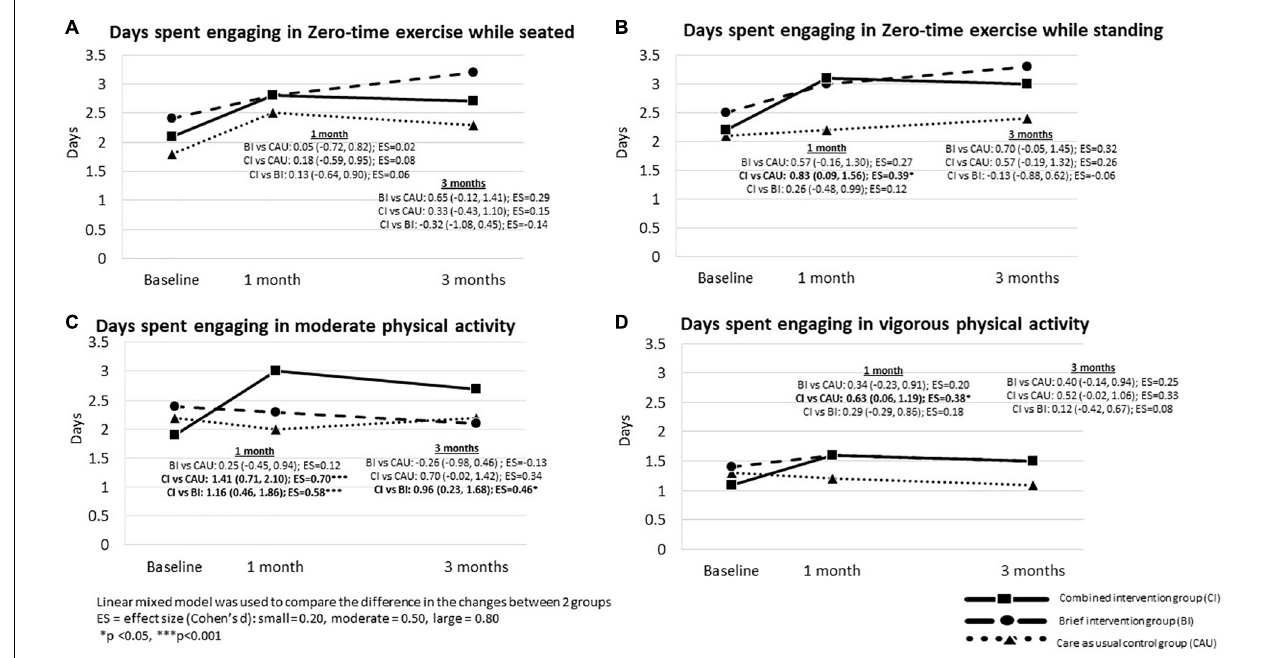
FIGURE 3 | The between –group difference in the changes in physical activity at 1- and 3-month follow-up in three groups: Intention-to-treat analysis.